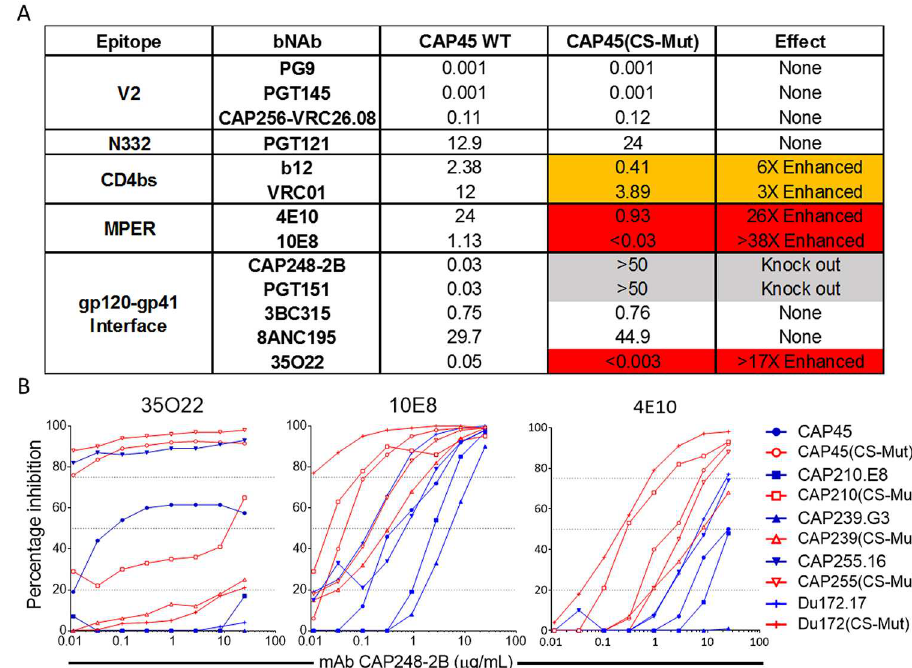
Fig 9. Escape mutations from CAP248-2Benhance the neutralization of broadly neutralizing antibodies that bind to gp41. (A) Neutralization of CAP45 and a mutant variant that includesthe six gp120 C-terminal mutations identified in CAP248autologoussequences(CS-Mut), by broadly neutralizing antibodies with epitopes in V2, V3, the CD4bs, the MPER, and the gp120-gp41interface. Fold changesless than three are within the variation of the assay (no effect). Fold enhancement in neutralization sensitivity to CAP248-2B is indicatedin orange(3–10 fold increasedsensitivity) and red ( > 10 fold increasedsensitivity). Conferred resistanceto the mutant virus at IC 50 is shown by grey shading. (B) Neutralization of five pairedWT (blue) and CS-Mut (red) viruses by 35O22, 10E8, and